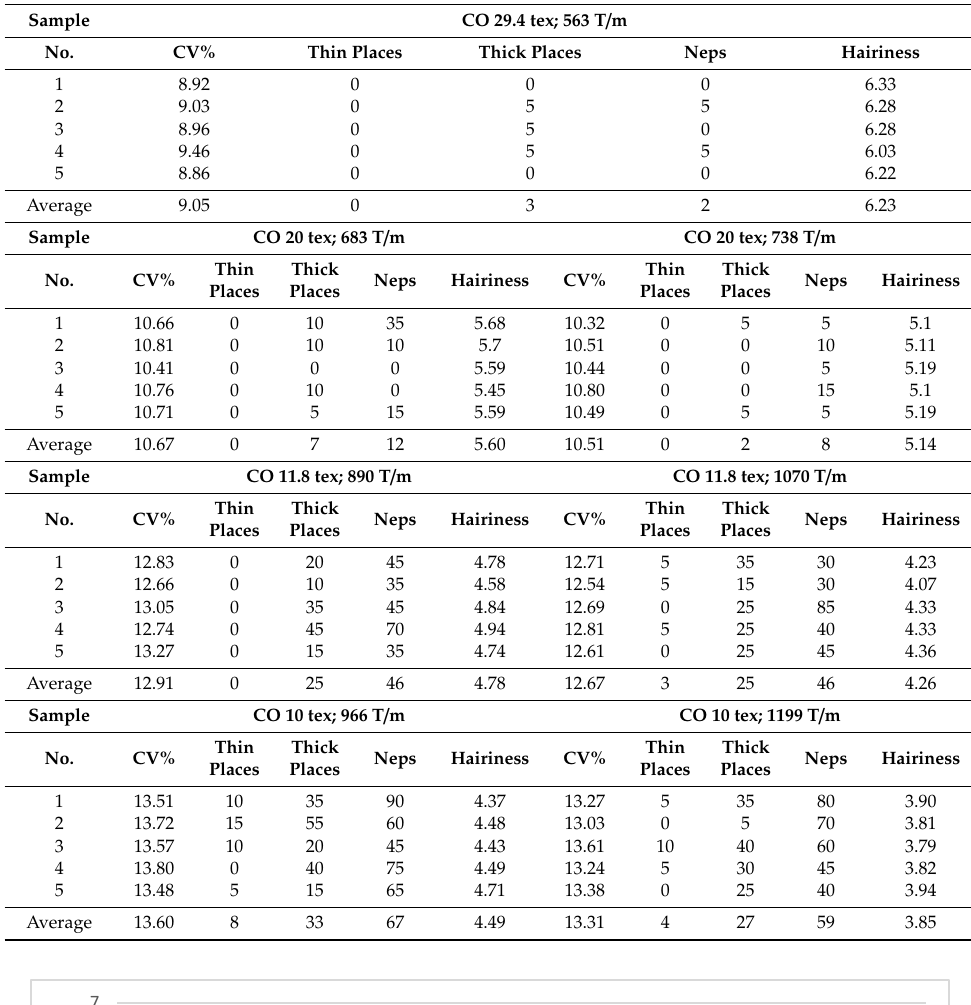
Table 8. Hairiness, neps, thin and thick places analyzed yarn.